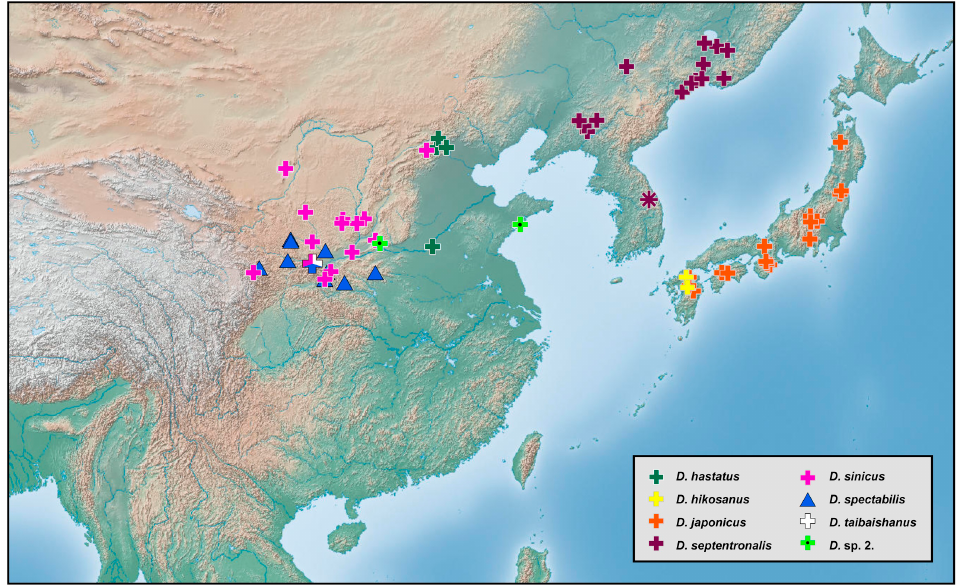
Figure 24. Distribution map of the species of Dilar from the Palearctic part of East Asia (Region 5 in Figure 19). Asterisk indicates specimen with imprecise locality.